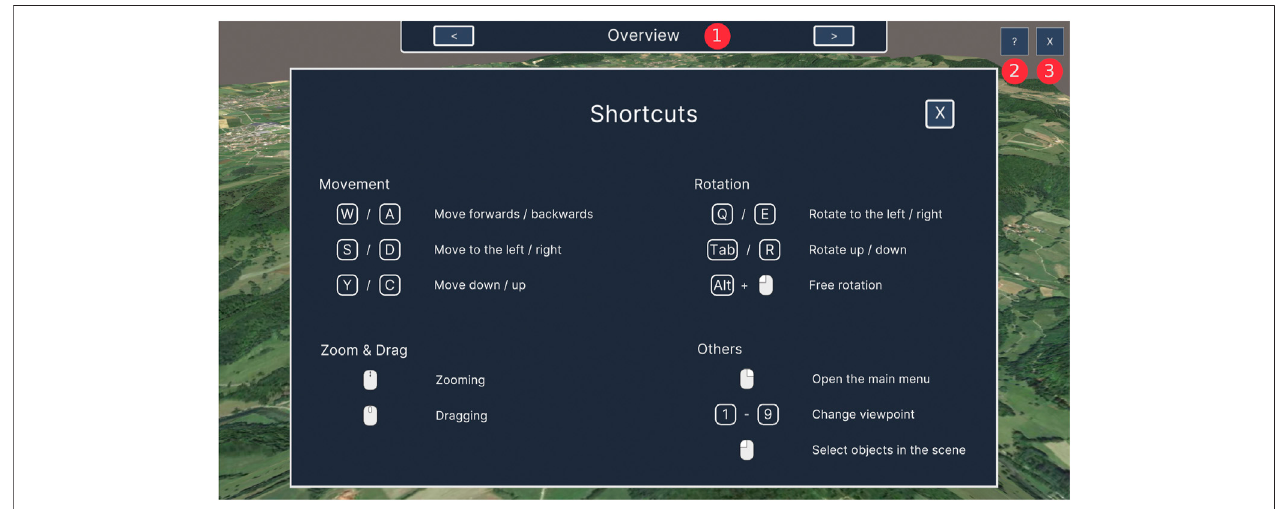
FIGURE 12 | The shortcut overview and the basic UI elements: Viewpoint Navigation (1), help button (2) and exit button (3).